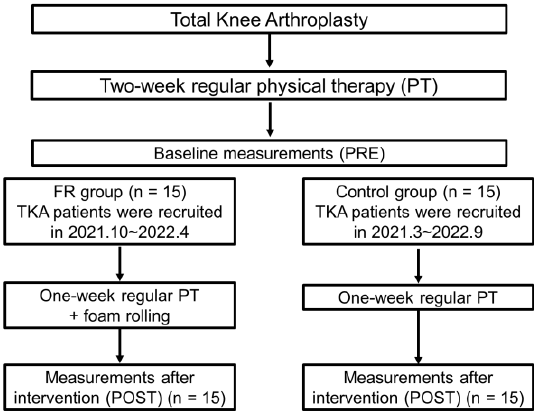
Figure 1. Flow chart of the study protocol.